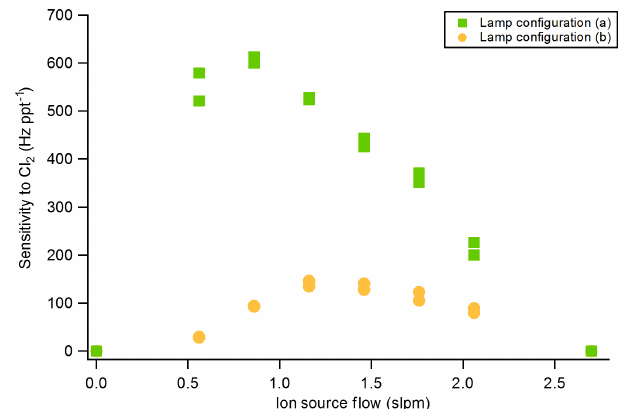
Figure 2. Q-CIMS sensitivity to Cl 2 · I − ( m/z = 197amu) as a func- tion of total ion source flow using the VUV-IS with lamp configu- ration (a) and